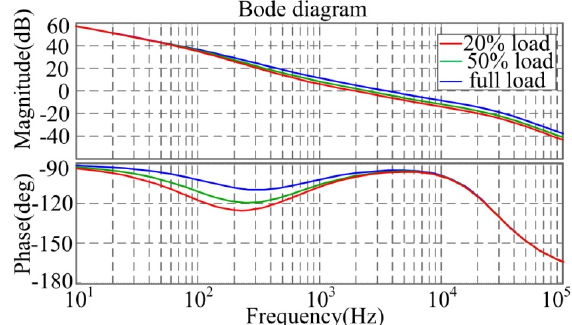
Figure 22. Frequency response of T ( s ) under different load currents with the adaptive controller.